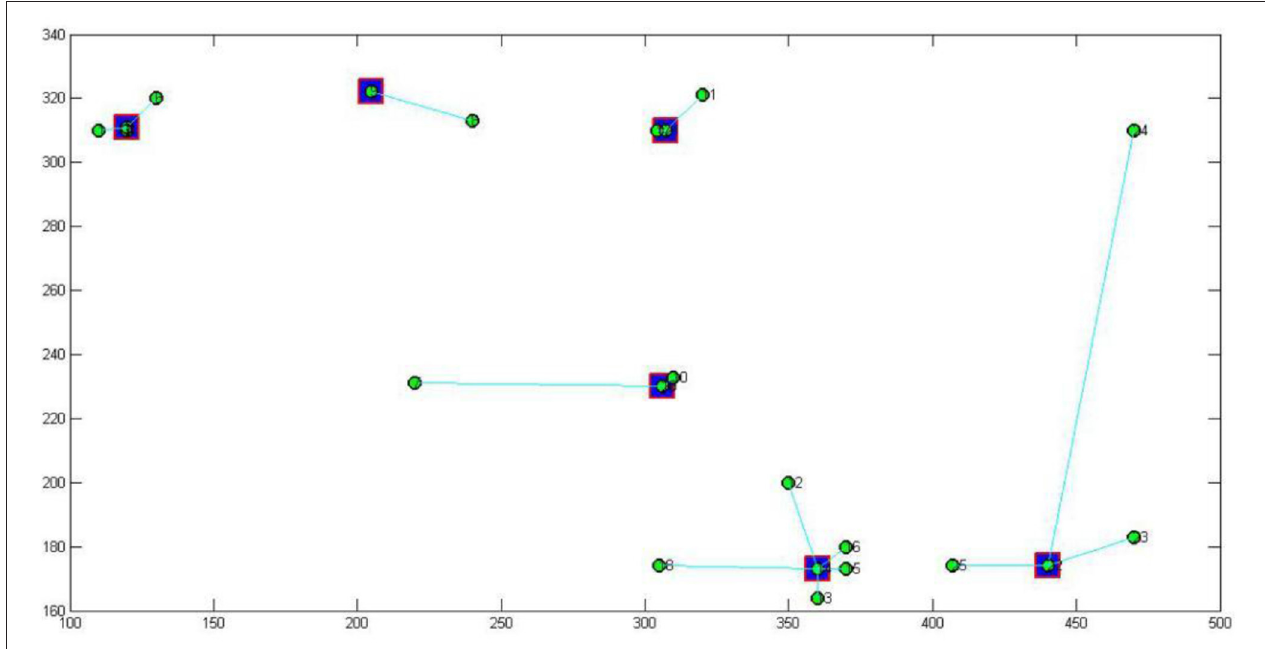
FIGURE 6 | Key Nodes in the Distribution Network of Case 1.